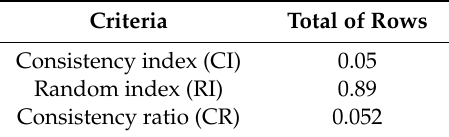
Table 9. Consistency